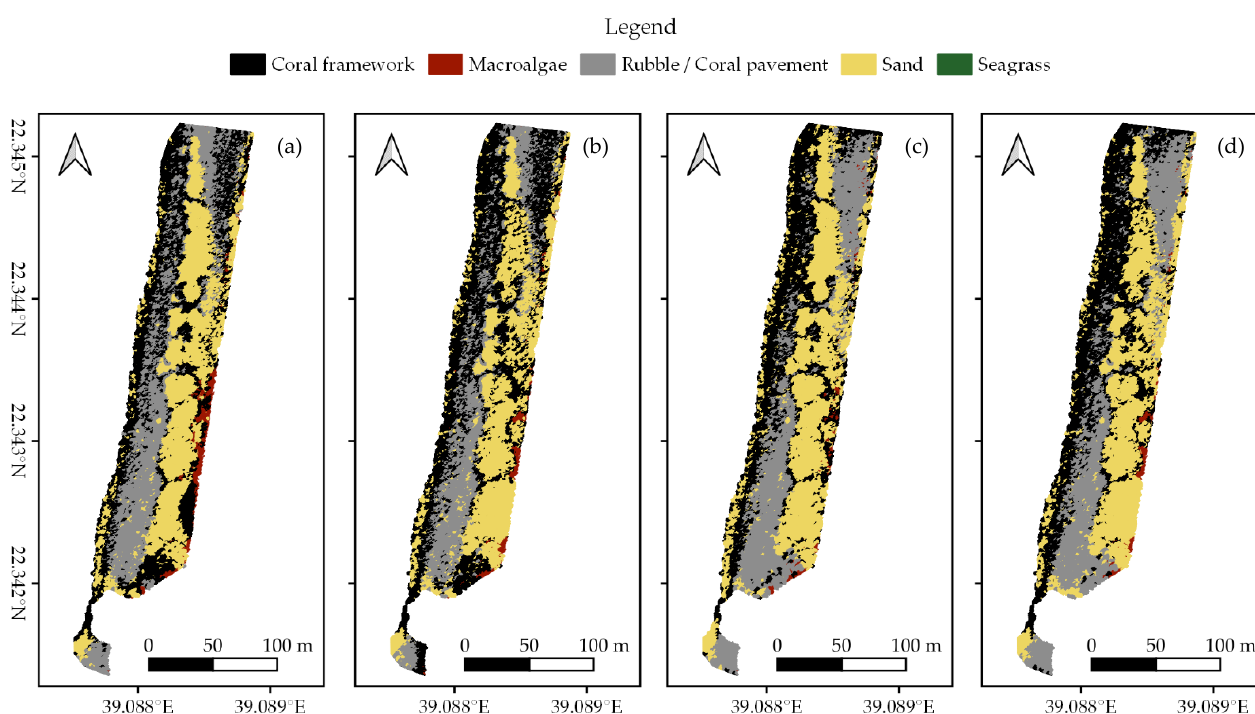
Figure 3. Habitat classifications of Area 1 (Figure 1) for classification protocol ( a ) 1. ‘Traditional classification’; ( b ) 2. ‘Using reef zones’; ( c ) 3. ‘Using geomorphometric features’; ( d ) 4. ‘Reef zones and geomorphometric features’ (Table 2).